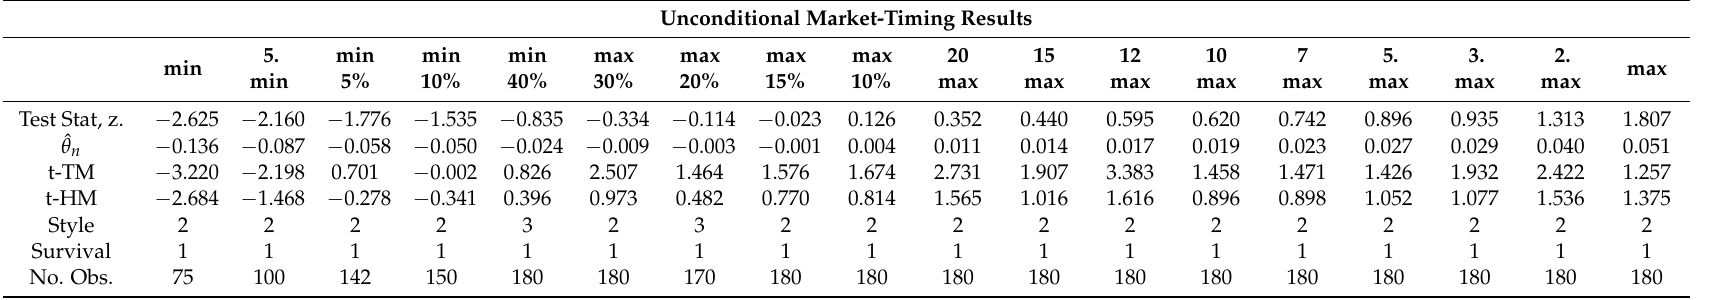
Table 3. Securities Investment Fund Market-Timing Performance—Unconditional